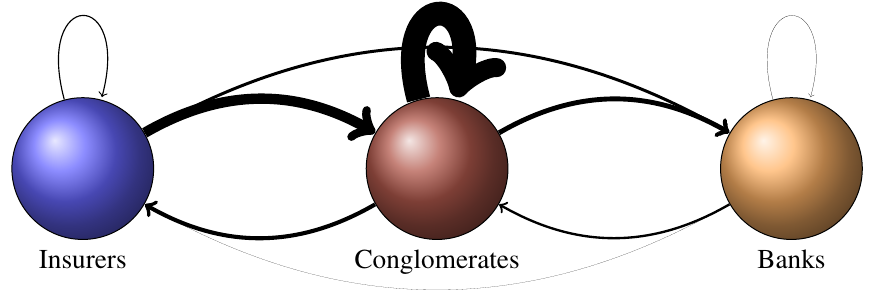
Figure 3. Volume of total exposures allocation between sectors. The node color indicates the institution class (red for conglomerates, blue for pure insurers and yellow for pure banks); the edge width is proportional to exposure. The arrow starts from the owner of the exposure and ends at the counterpart with a left bent profile. Loop arrows represent exposure within the class considered. Source: ACPR Data, authors’